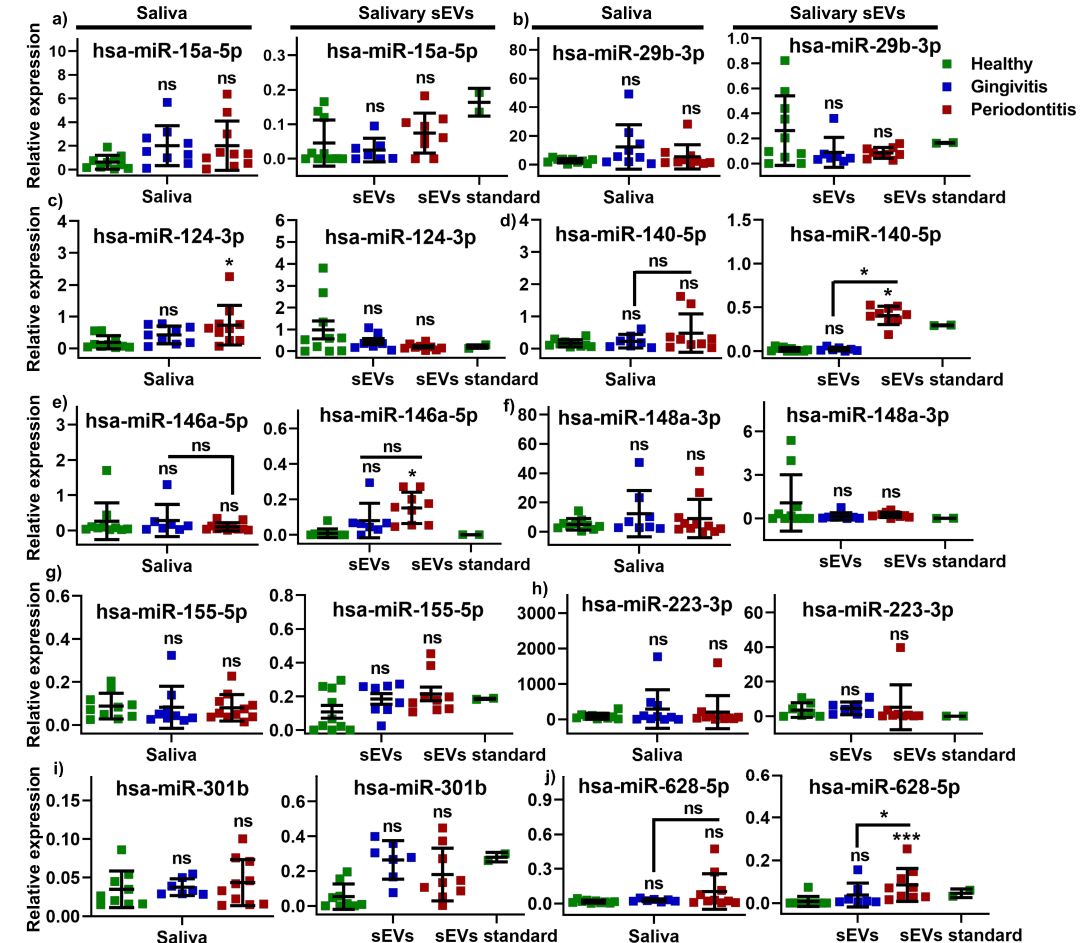
Figure 2. The relative expression levels of microRNAs (miRNAs): hsa-miR-15a-5p ( a ), hsa-miR-29b-3p ( b ), hsa-miR-124-3p ( c ), hsa-miR-140-5p ( d ), hsa-miR-146a-5p ( e ), hsa-miR-148a-3p ( f ), hsa-miR-155-5p ( g ), hsa-miR-223-3p ( h ), hsa-miR-301b ( i ) and hsa-miR-628-5p ( j ) miRNA detected by qRT-PCR in salivary sEVs and saliva samples from gingivitis, periodontitis patients, compared to healthy subjects. No significant difference vs healthy group (ns). * p < 0.05 vs healthy group; *** p < 0.0002 vs healthy control.